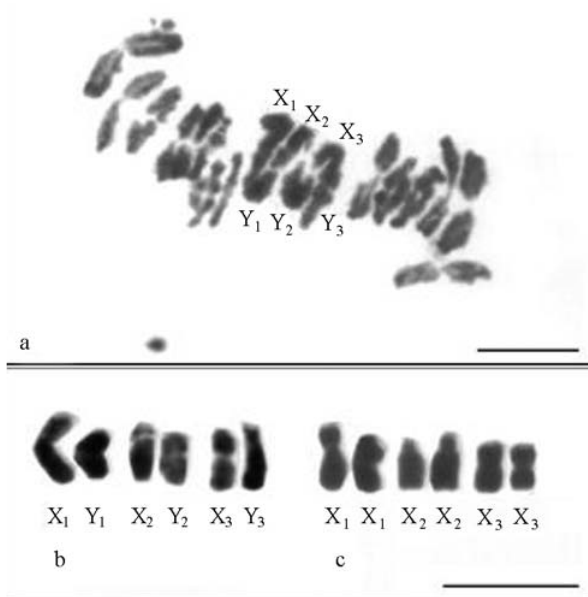
Figure 2 - Conventionally stained meiotic and mitotic chromosomes of Euchroma gigantea . (a) Metaphase I with 2n = 34. Observe the alternate chain formed by the (X 1 Y 1 X 2 Y 2 X 3 Y 3 ) sex chromosomes. (b) and (c) Sex chromosomes of a male and of a female, respectively. Bar = 10 μ m.